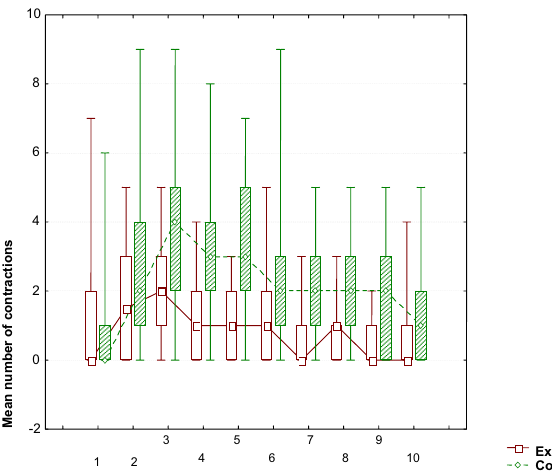
FIGURE 3 - Number of contractions minute by minute in the groups studied